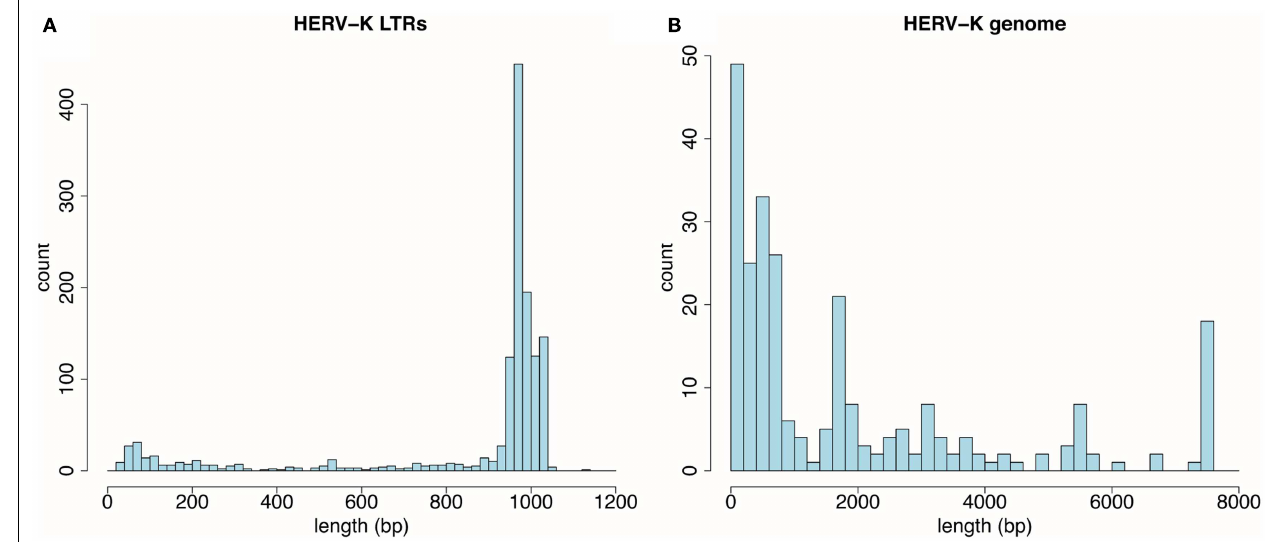
fragments are plotted as function of 20bp length windows. (B) Two hundred fifty-five HERV-K provirus internal genome segments are plotted as a function of 200bp length